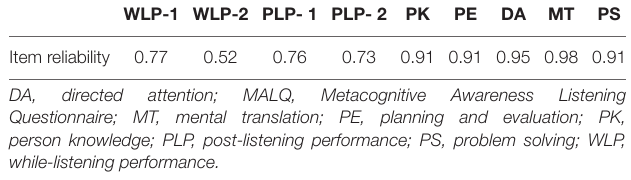
TABLE 2 | Rasch item reliability of the four listening tests and the five subscales of the